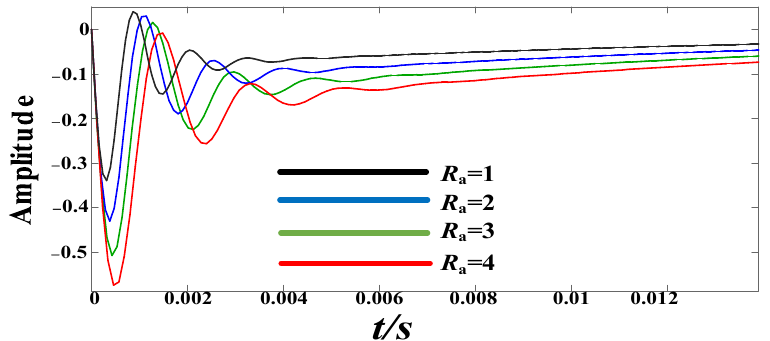
Figure 10. Unit step response curves under different R a .